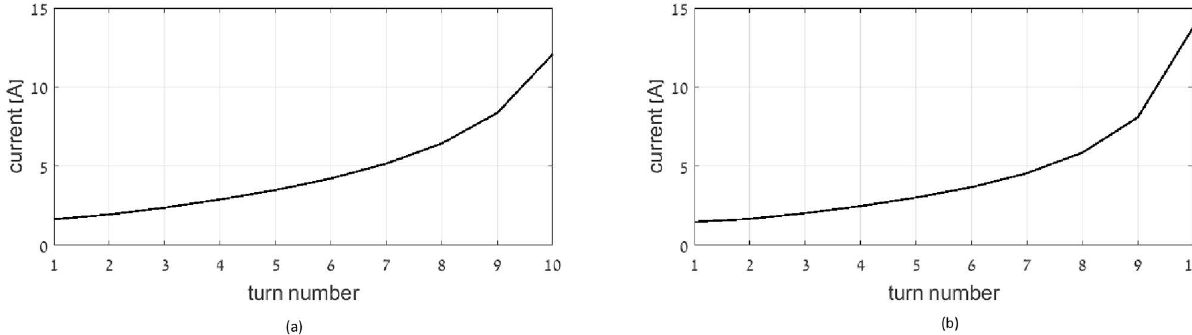
Fig 11. Current distribution in optimal flat coil: wire radius: (a) 0.1 mm, (b) 0.5 mm.